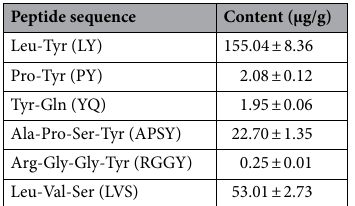
Table 5. Quantitative analysis of active peptides in